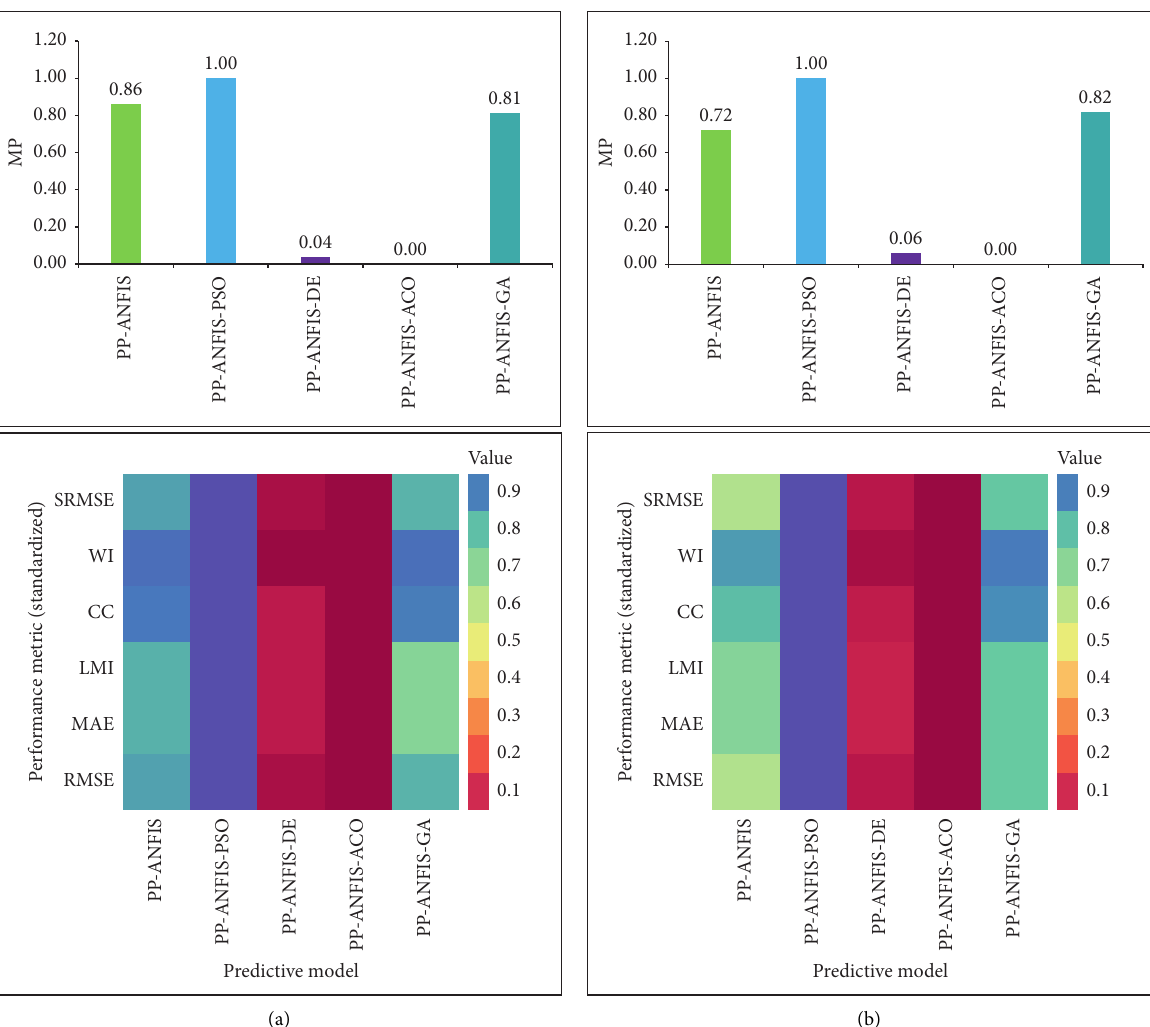
Figure 4: The mean performance index and heat graph presentations for the applied hybrid ANFIS models using the preprocessed data (PP) scenario: (a) training phase and (b) testing